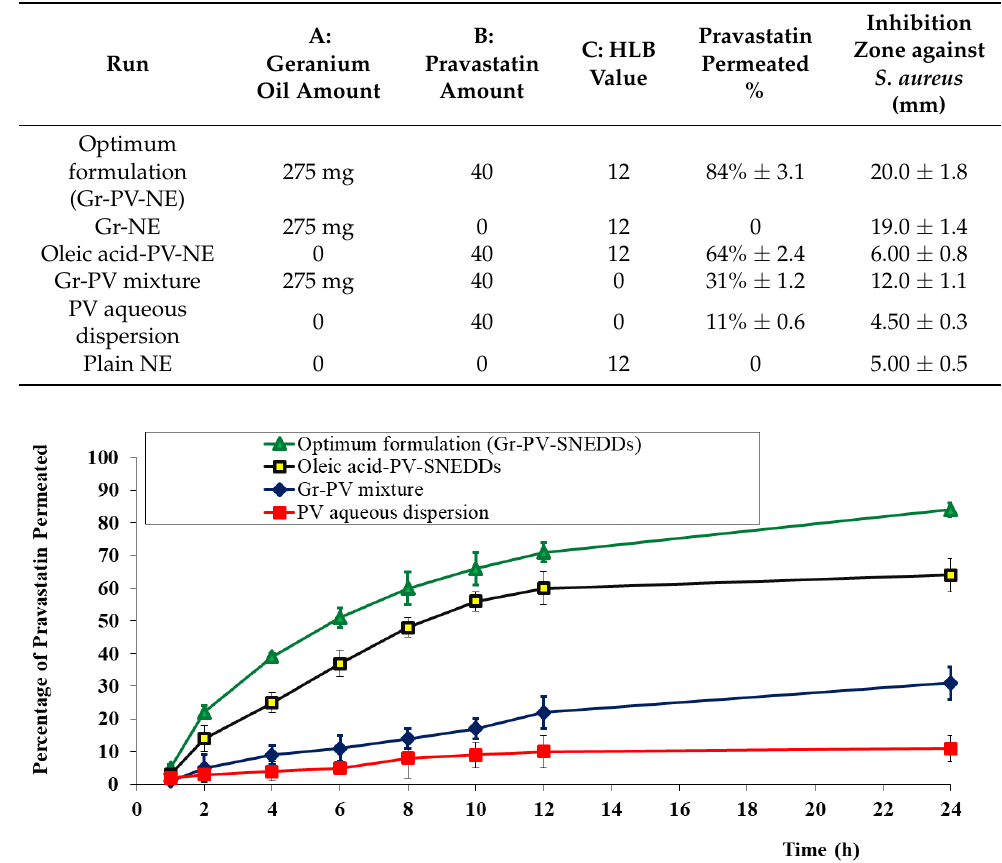
Figure 7. Ex-vivo permeation profiles of PV from different tested formulations.